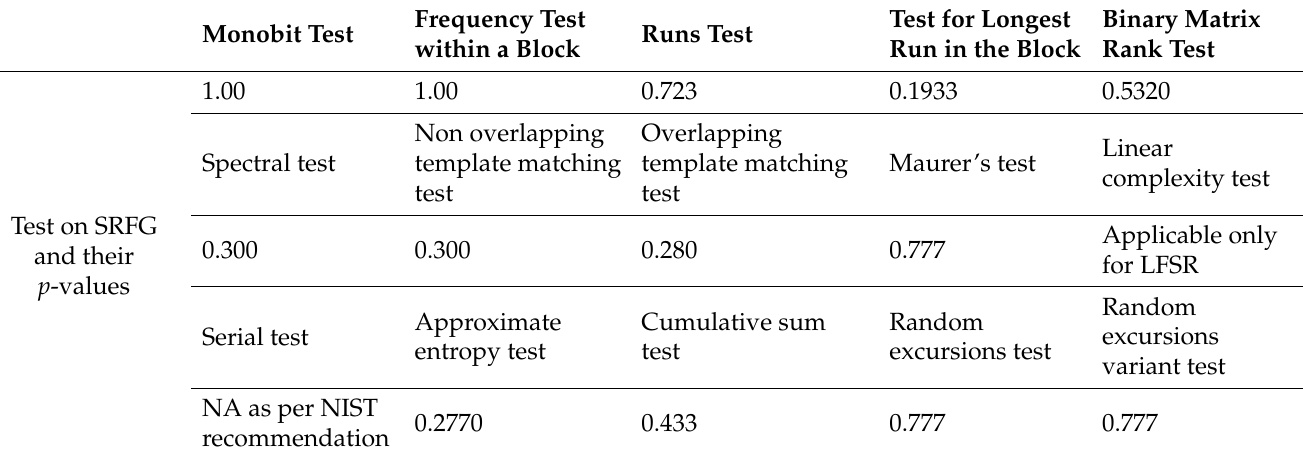
Table 3. p -values of statistical tests on